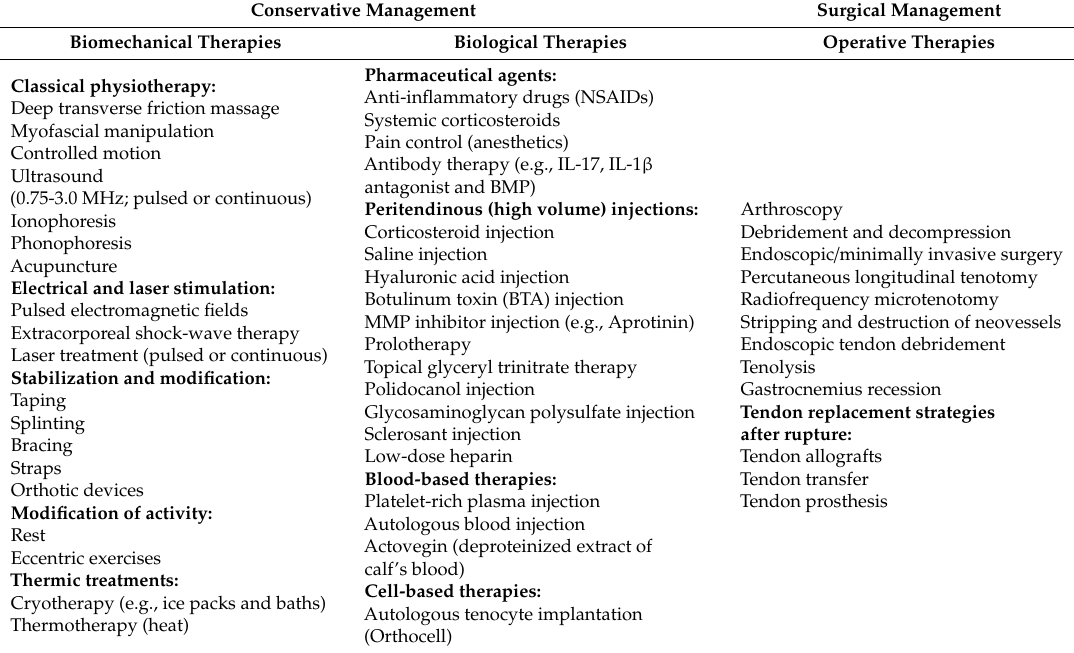
Table 1. Current options of tendinopathy